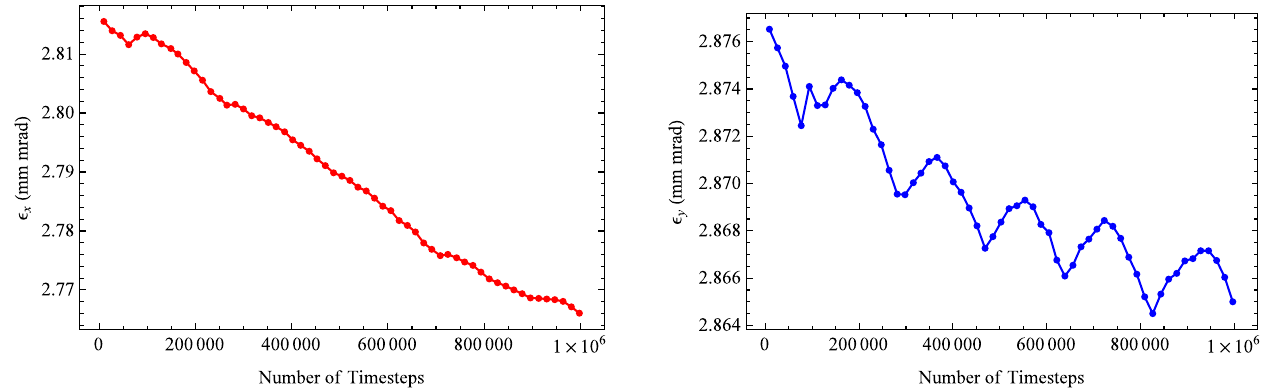
FIG. 20. Maxima of the horizontal (left) and vertical (right) emittances curves of the proton beam bunch of 1 cm radius cooled with a 5 mm electron beam radius, B